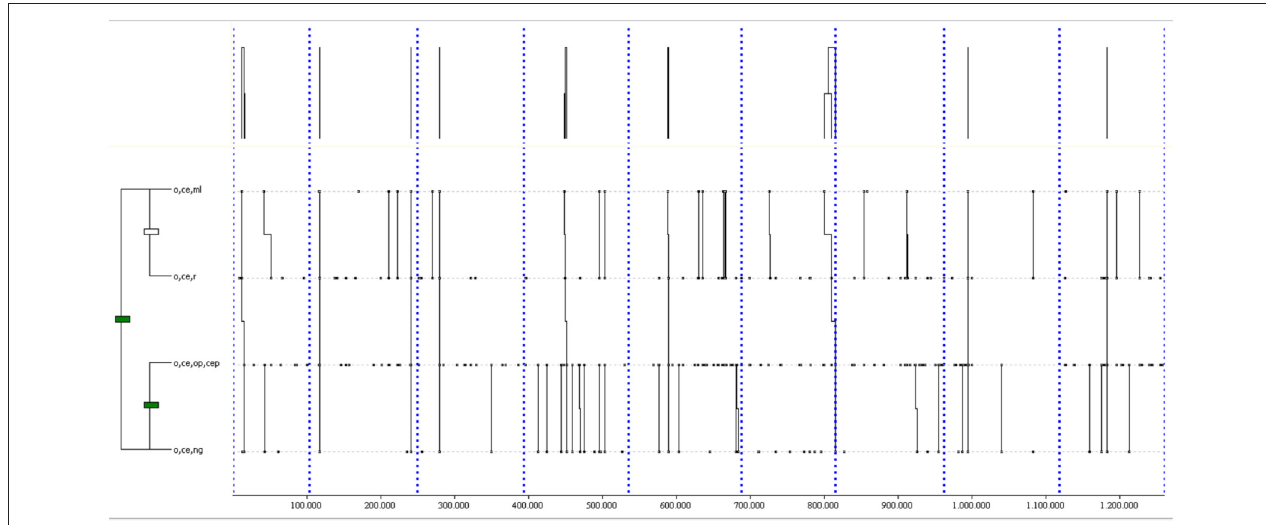
FIGURE 6 | The most complex T-pattern from away matches with a NoGoal. It occurred in over 80% of the games analyzed. Events are (1) o,ce,ml; (2) o,ce,r; (3) o,ce,op,cep; and (4)